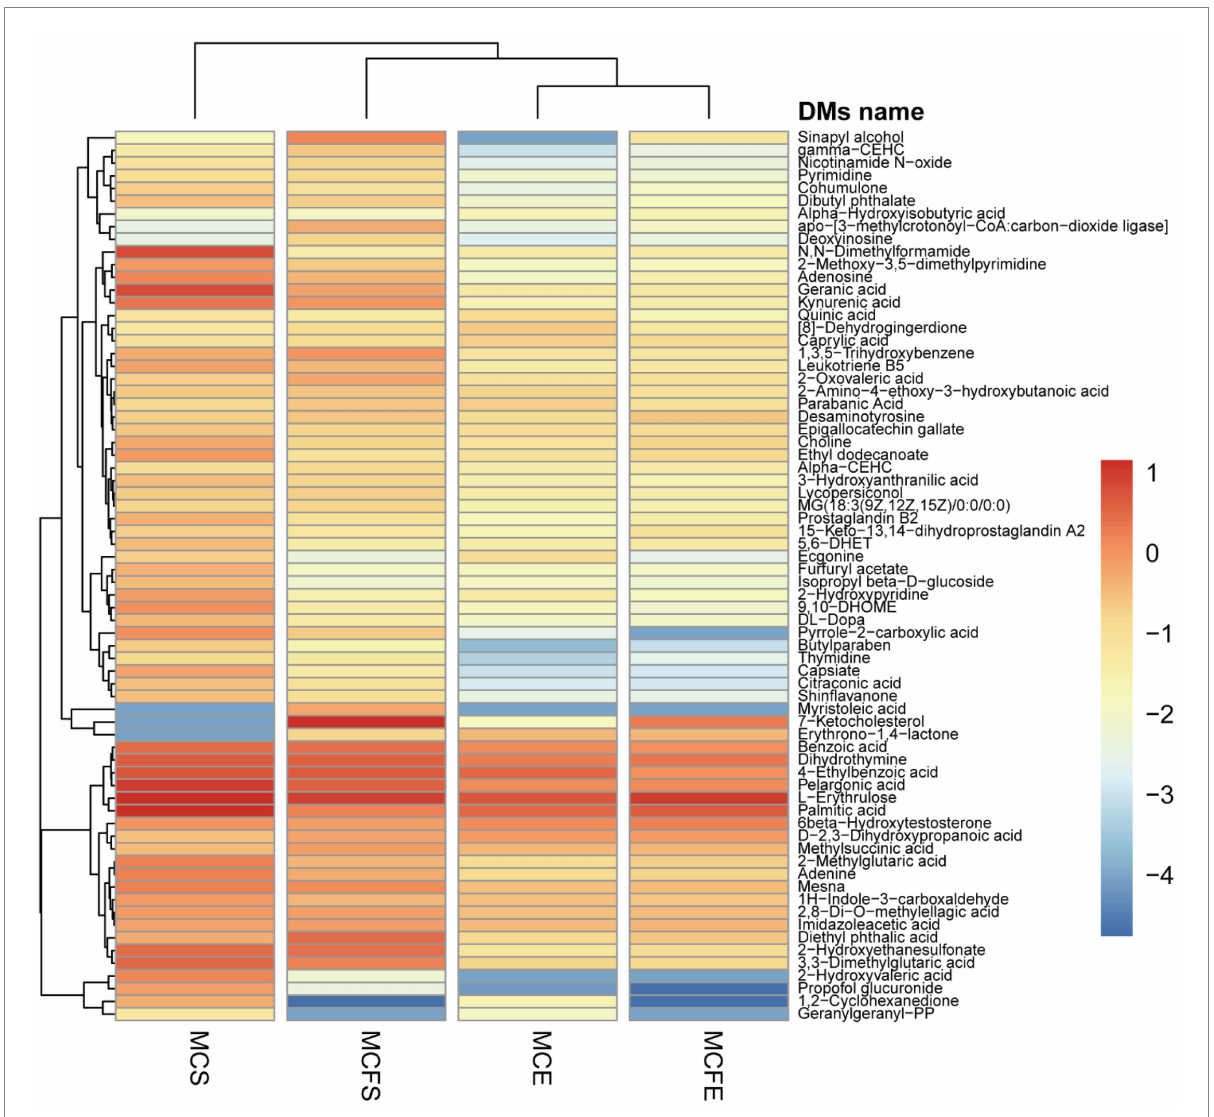
FIGURE 5 Heatmap for differential metabolites based upon hierarchical clustering of the four groups. The x -axis represents the four experimental groups, the y -axis the differential metabolites. The color blocks represent the relative concentration of metabolites at the corresponding positions. MCE, MC-producing strain at exponential phase; MCFE, MC-free strain at exponential phase; MCS, MC-producing strain at stationary phase; MCFS, MC- free strain at stationary